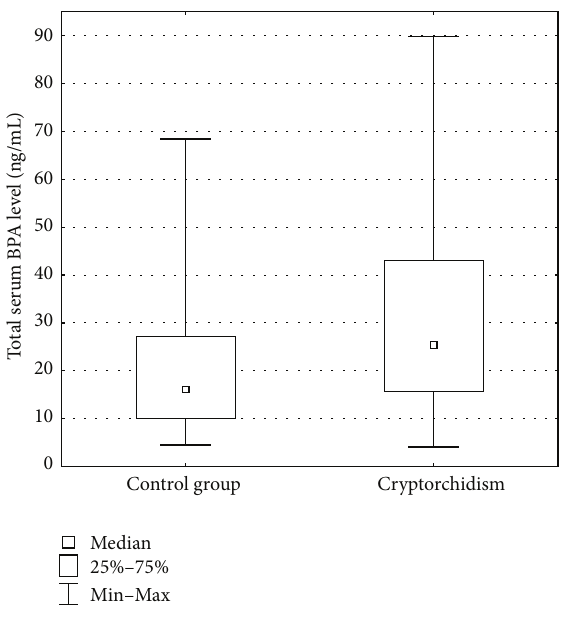
Figure 3: Total serum BPA level